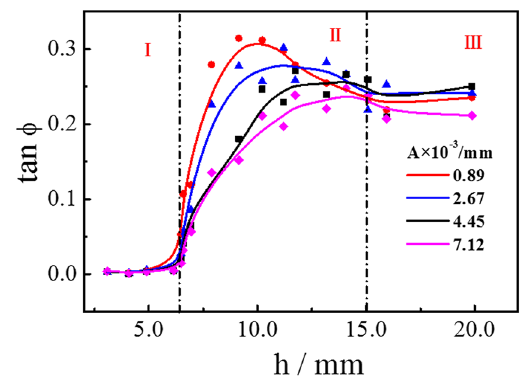
Fig. 3. Dependence of the immersed depth h on the tanϕ for glass beads with a diameter of 0.1±0.05 mm at different shear strain